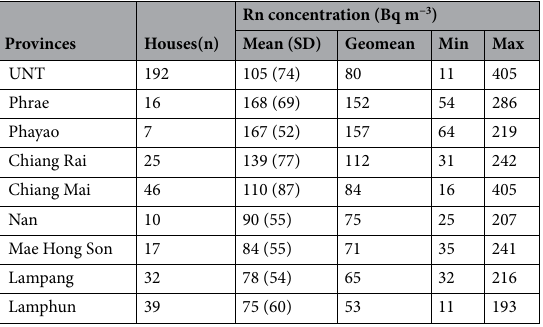
Table 1. Arithmetic and geometric means of indoor radon concentrations in eight provinces of upper northern Thailand